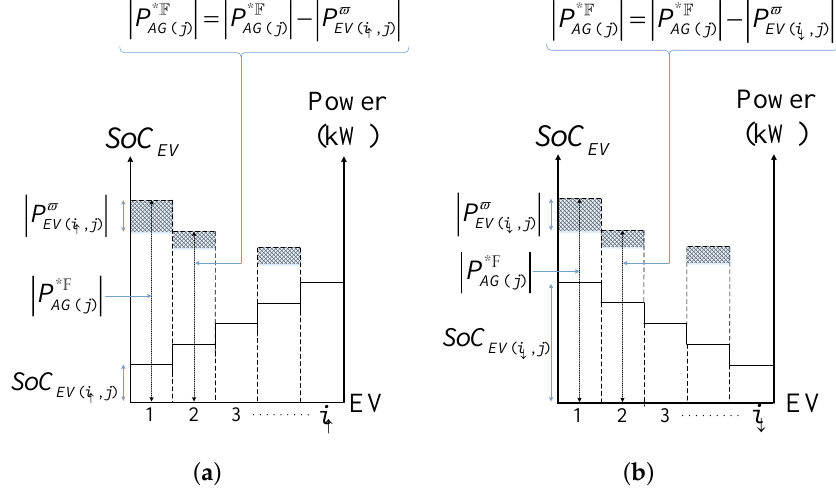
Figure 5. EV power allocation concept. ( a ) EVs arranged in monotonically increasing order of their SoC values for charging. ( b ) EVs arranged in monotonically decreasing order of their SoC values for discharging.